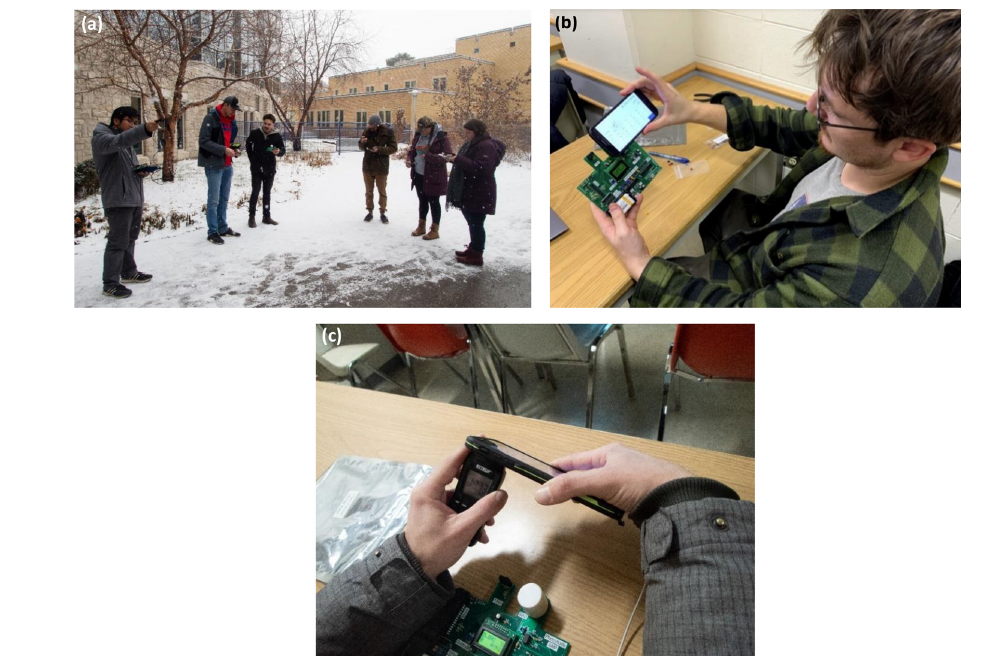
Figure 9. Students engaged in calibration activities. (a) Outdoor calibration of temperature, RH, and pyranometer devices using handheld commercial sensors. Indoor calibration (b, c) with a smartphone flashlight and a handheld solar radiation meter used as a standard for comparison.